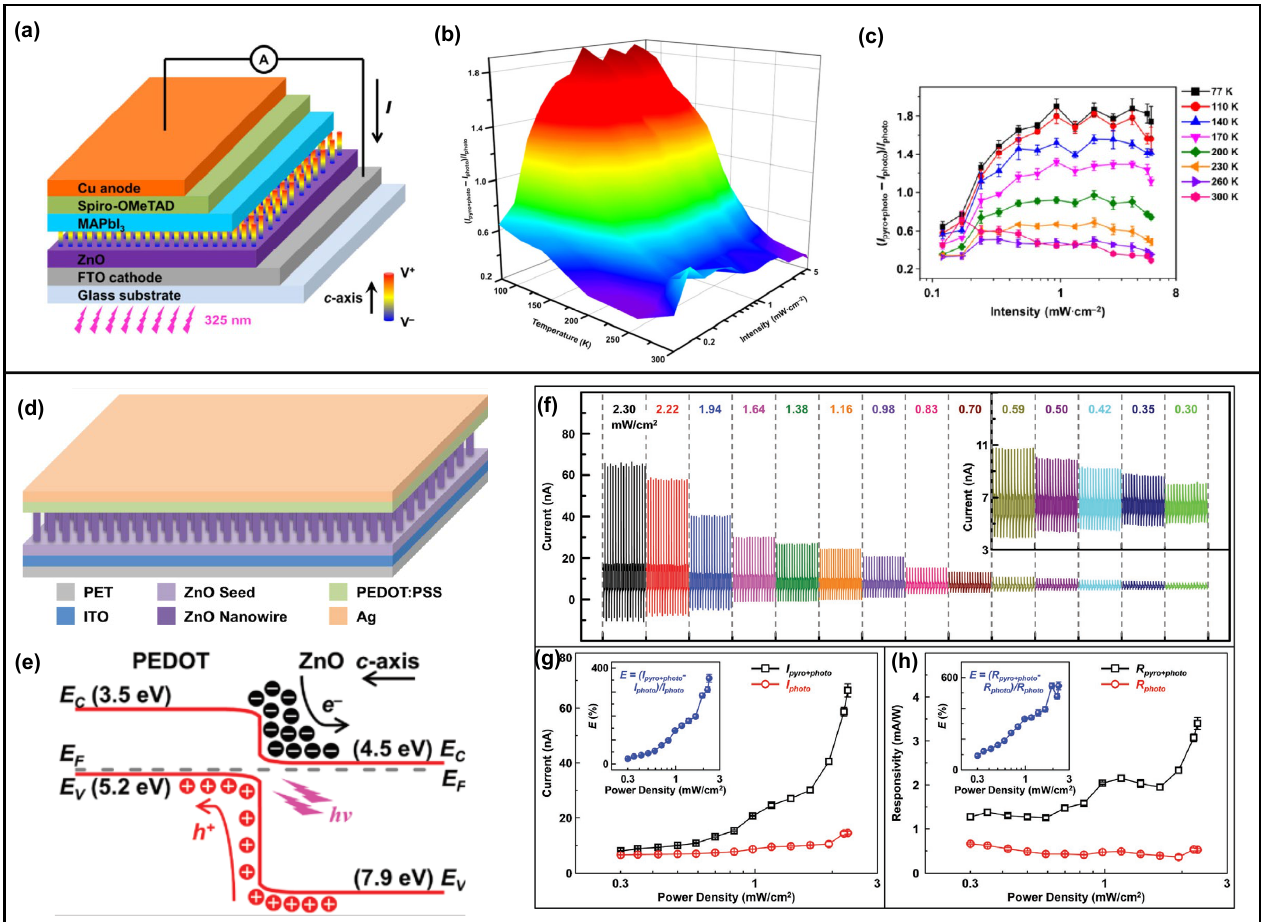
Figure 4. Pyro-phototronic-effect-enhanced photodetectors with heterostructure formed by ZnO and organic materials. ( a ) Schematic demonstration of the structure and operating mechanism of self-powered ZnO/perovskite heterostructured photodetectors; ( b ) 3D surface plot depicting the output-signal enhancement caused by the pyro-phototronic effect under different temperatures and light intensities; ( c ) Output-signal enhancement caused by the pyro-phototronic effect under different UV light intensities, with the temperature ranging from 77 to 300 K. Reproduced with permission from [42]. Copyright 2016 Springer; ( d ) Schematic demonstration of the structure of the PEDOT:PSS/ZnO heterojunction photodetector; ( e ) Energy band diagram of the PEDOT:PSS/ZnO heterojunction; ( f ) Transient characteristics of the pyro-phototronic-effect-enhanced photodetector under 325 nm UV laser with different power densities; ( g ) The pyro-phototronic-effect-induced I pyro + photo and the photovoltaic-effect-induced I photo as a function of the power density; ( h ) The corresponding R pyro + photo and R photo as a function of the power density. Reproduced with permission from [43]. Copyright 2017 Wiley.